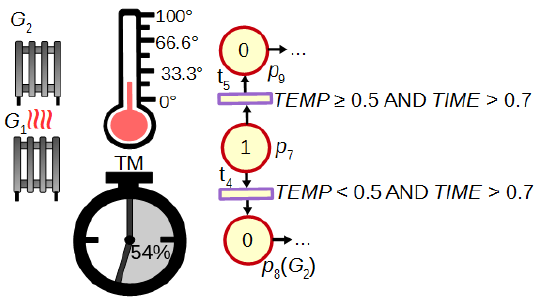
Figure 3. A dynamic control of